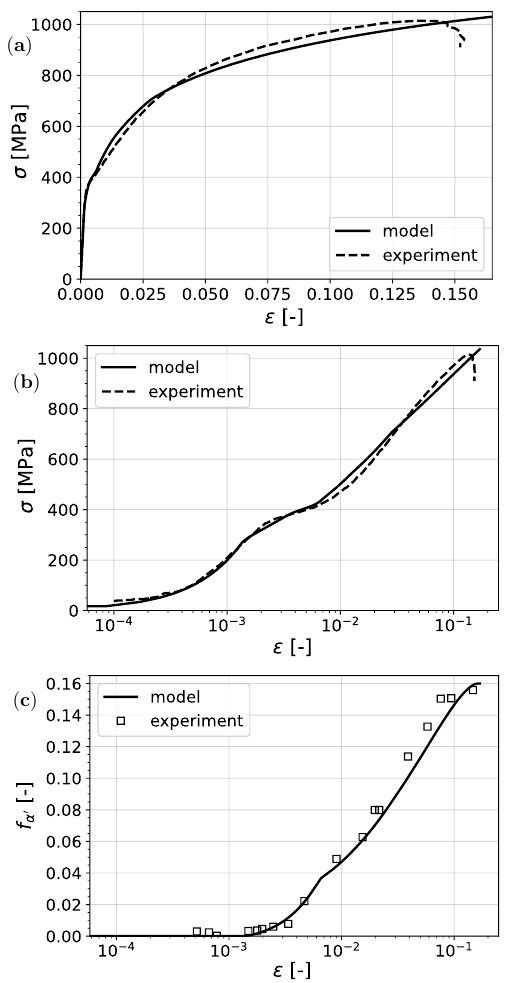
Figure 6. Prediction of the model compared to experimental results by Ennis et al. [61]: ( a ) stress vs. strain, ( b ) stress vs. log strain, and ( c ) transformed martensite vs. log